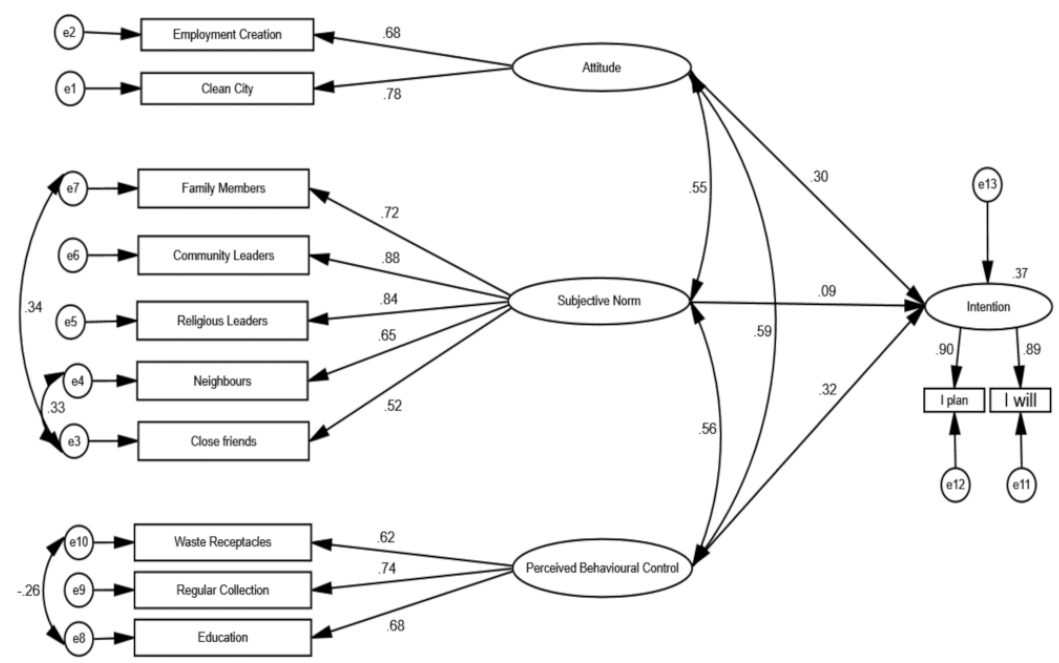
Figure 4. The default structural equation